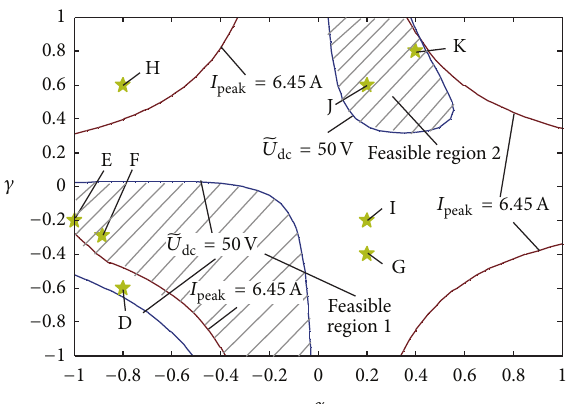
Figure 12: Feasible region for power control coefficients of photo- voltaic